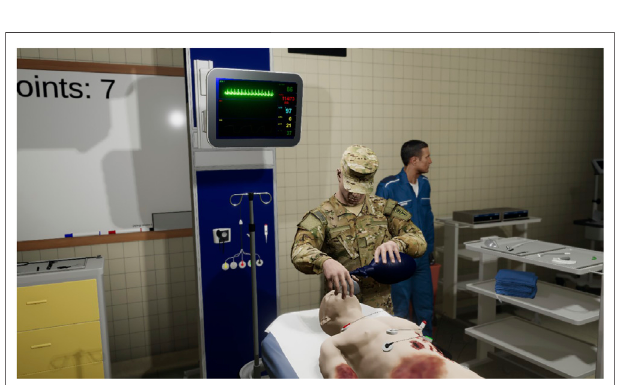
FIGURE 5 | A screenshot of a medic using a bag-valve-mask on a patientwithinternalhemorrhage.Thisisoneoftwonon-playercharacters that are present. The learner gives commands to these characters through point and click menus and via a hand tablet interface.